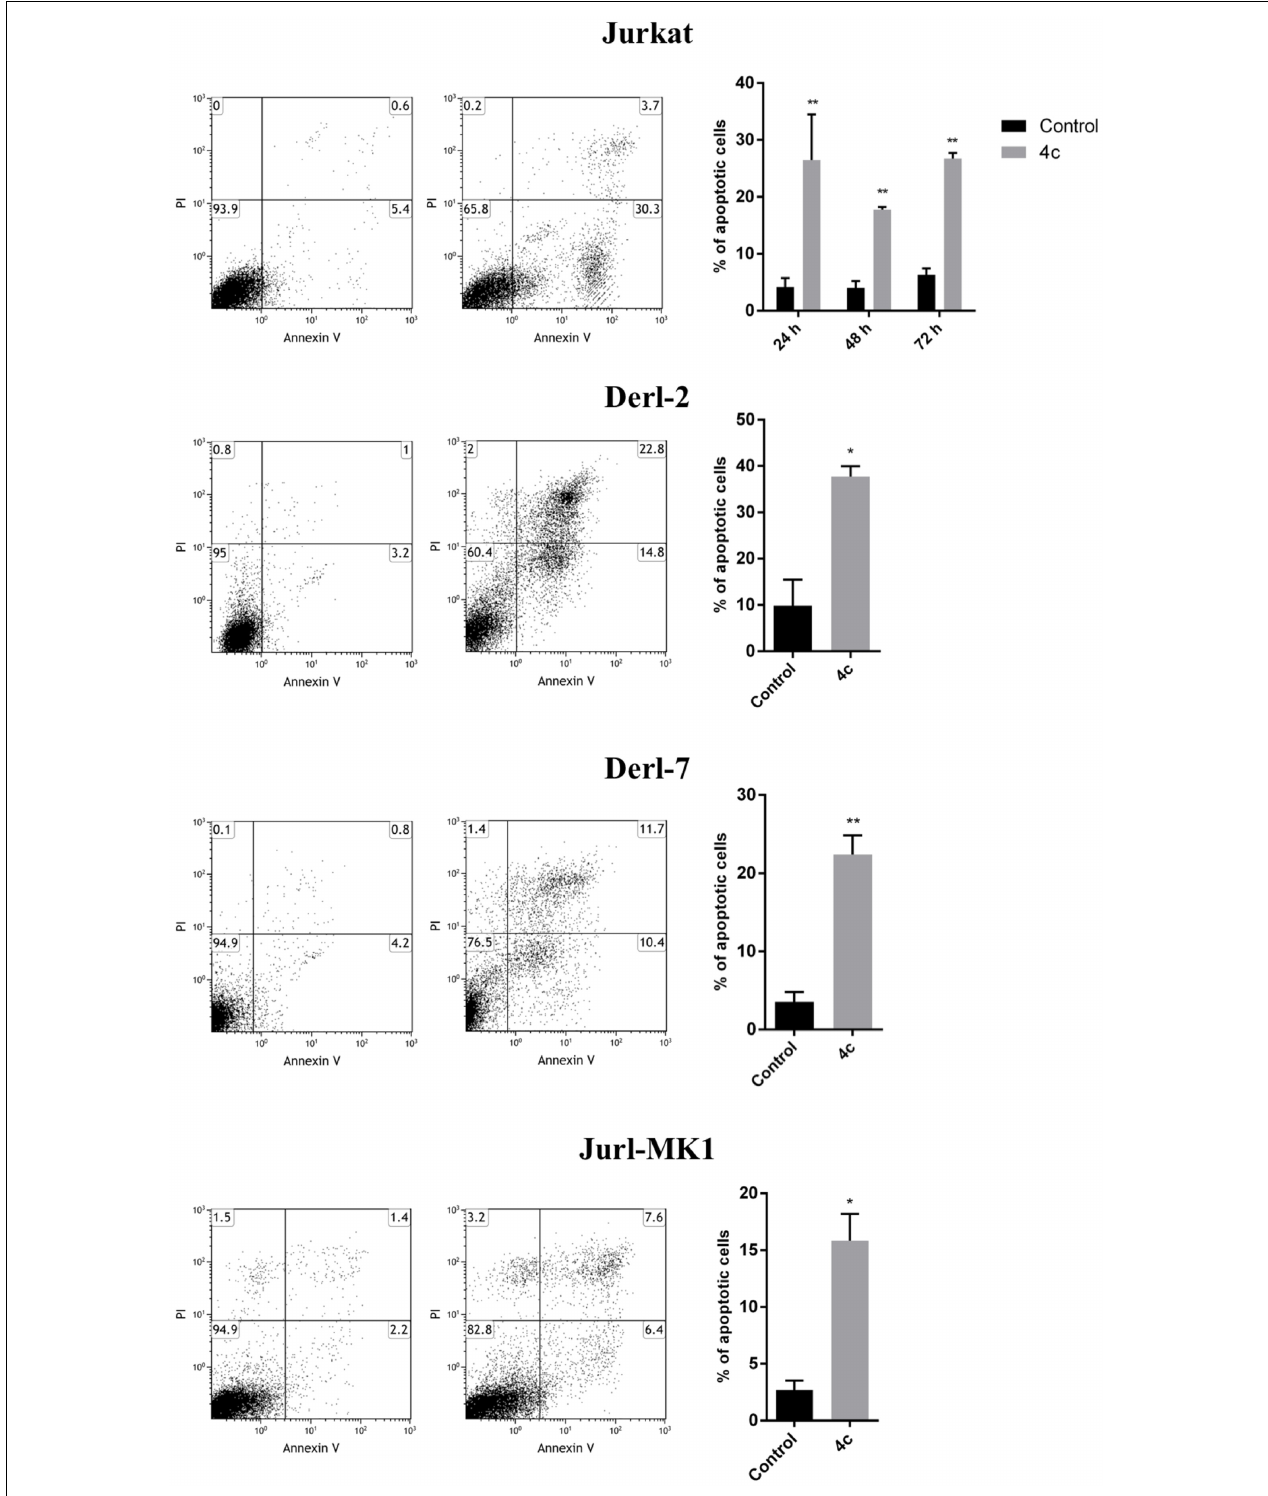
FIGURE 2 | Apoptosis analysis in hematological malignancies after 4c compound treatment. Apoptosis was evaluated by flow cytometer in Jurkat cell line after 4c compound or DMSO vehicle treatment at 2 µ M for 24, 48, and 72 h; in Derl-2 and Derl-7 after treatment at 4 µ M for 72 h; in Jurl-MK1 after treatment at 1 µ M for 72 h. Dot plots show a single representative experiment, the bar-graphs represent mean with SD from three independent experiments. ∗ and ∗∗ indicated a P -value minor than 0.05 and 0.01, respectively.